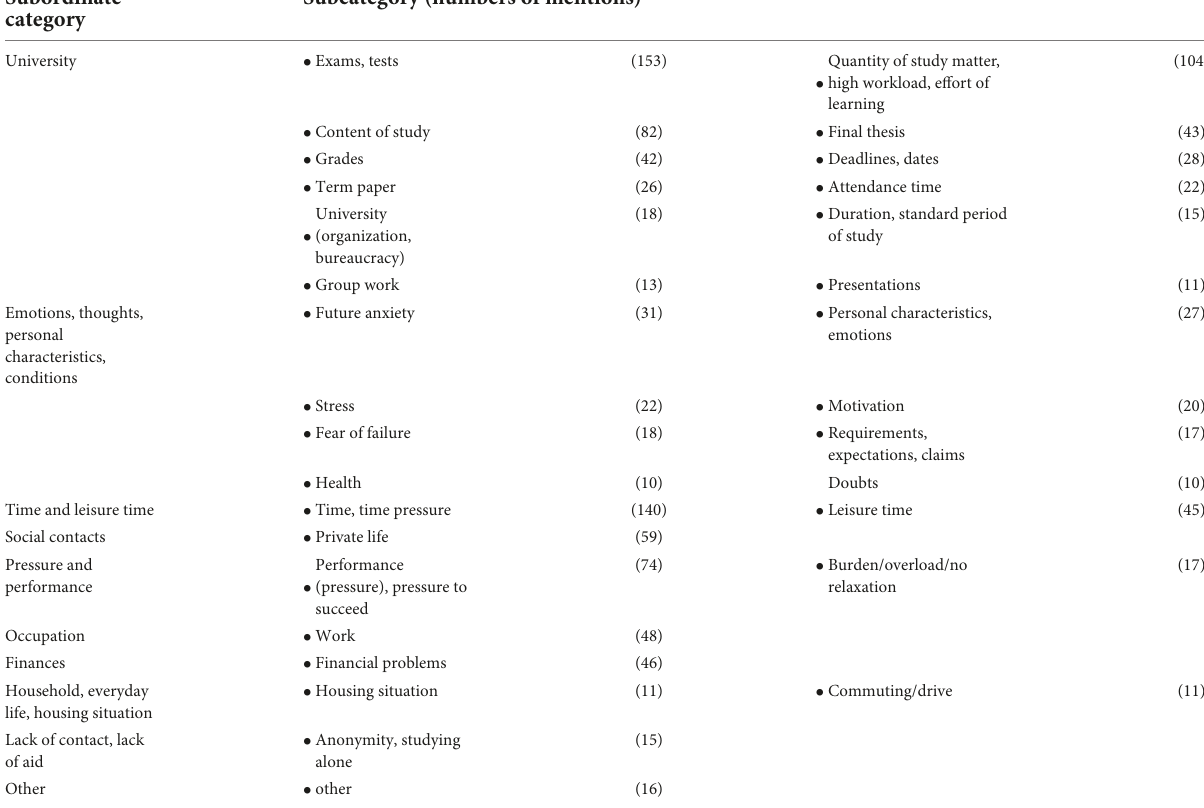
TABLE 3 Superordinate categories and subcategories of areas of